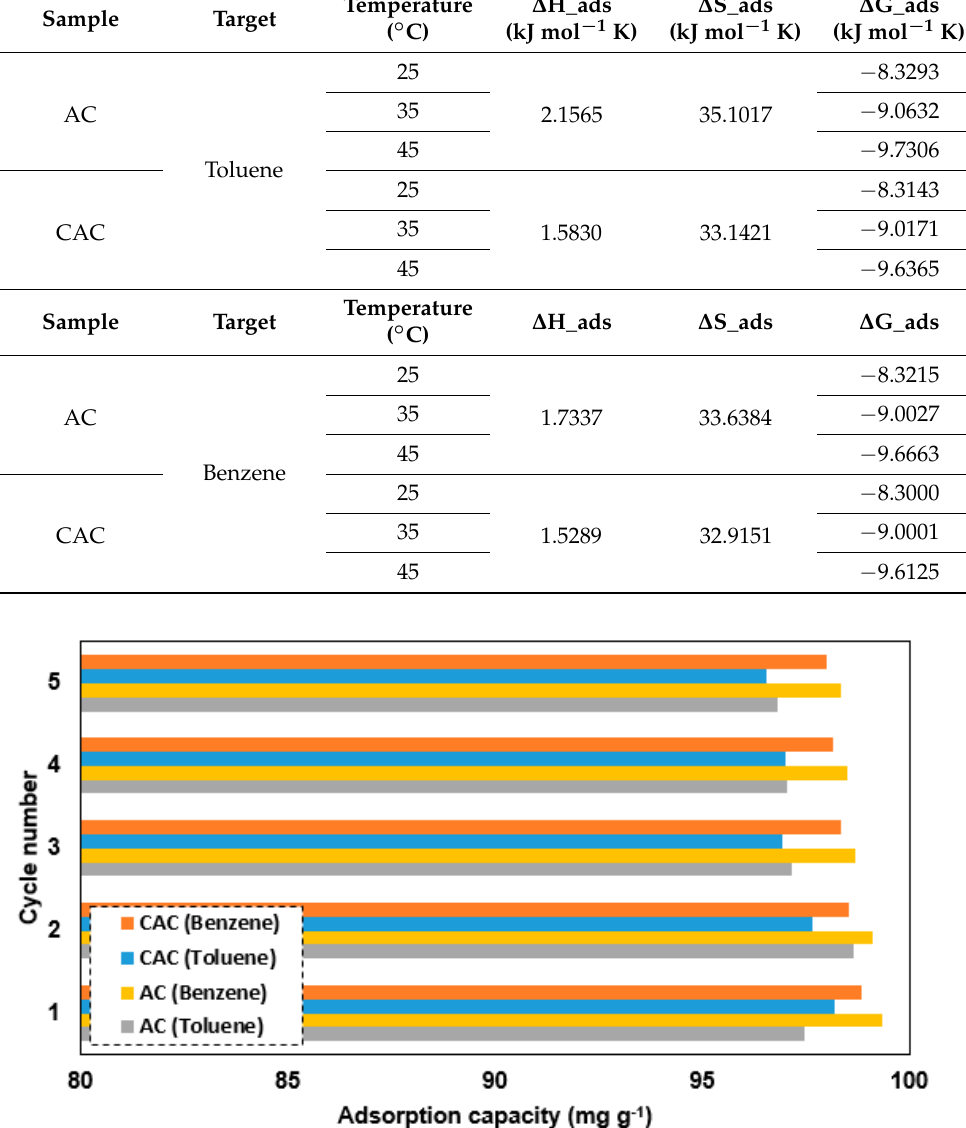
Figure 5. Regeneration e ffi ciency of samples (3 g) with 50 mg L − 1 of selected VOCs.